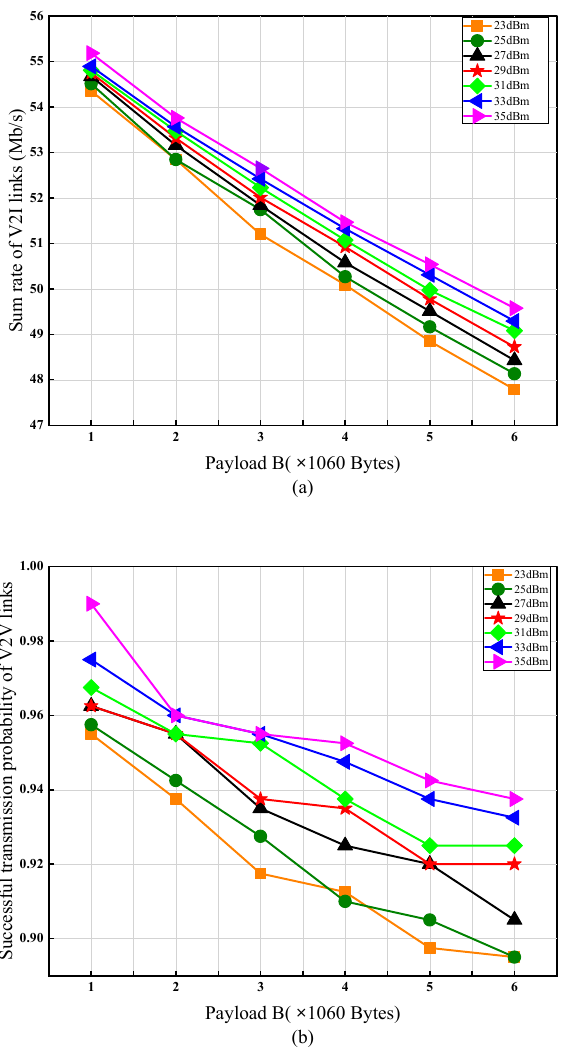
Figure 6. The performance comparisons for different V2V links transmission power: ( a ) Sum rate of V2I links. ( b ) Successful transmission probability of V2V links.